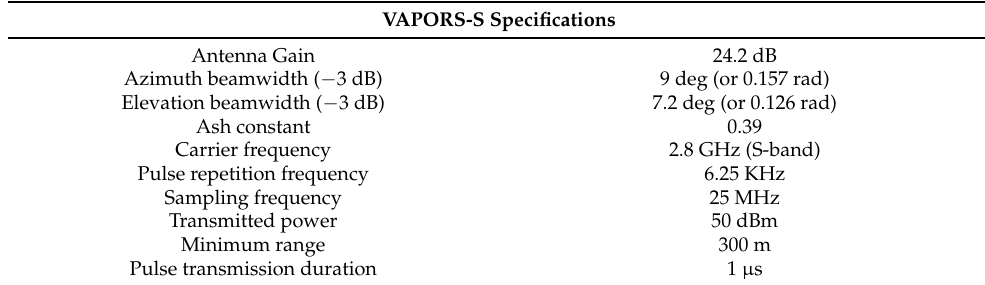
Table 1. VAPORS-S technical